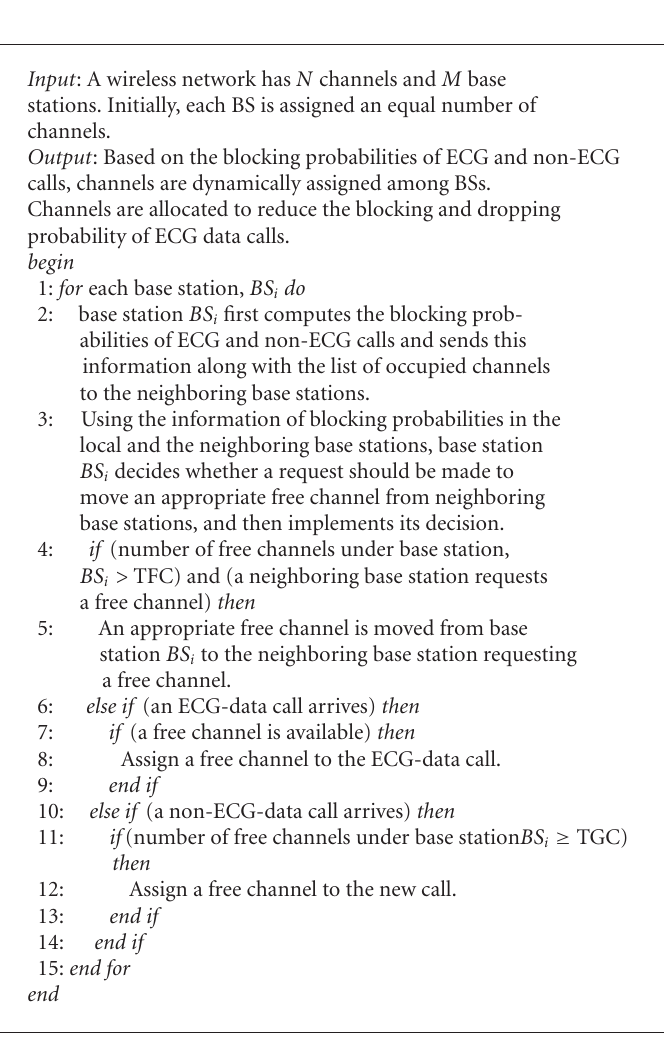
Algorithm 1: Algorithm